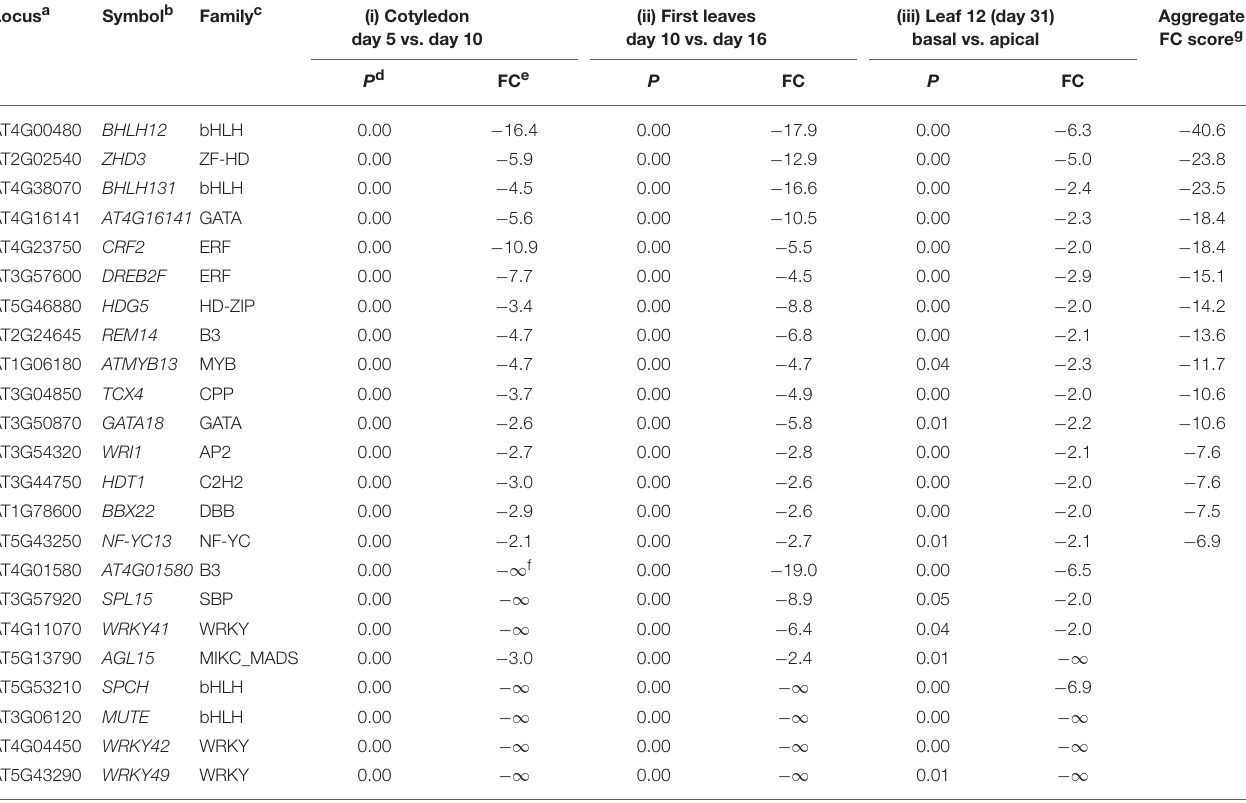
TABLE 3 | Transcription factors (23 in total) showing differential down-regulation in all three experimental comparisons analyzing wall ingrowth deposition in PP TCs of Arabidopsis. Locus a Symbol